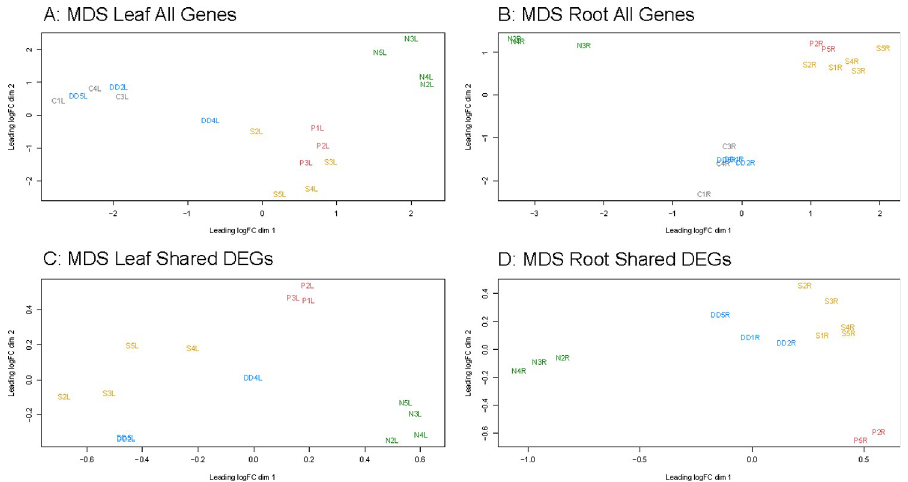
Fig 3. MDS plots illustrating the transcriptomic response to each stress across samples. (A) MDS plot based on the expression values of all genes included in this analysis for leaf tissue and (B) root tissue. (C) MDS plots generated from the expression values of DEGs shared among all four stresses for leaf tissue and (D) root tissue. Control samples were not included in panels C and D as the genes under consideration in these analyses were by definition differentially expressed relative to